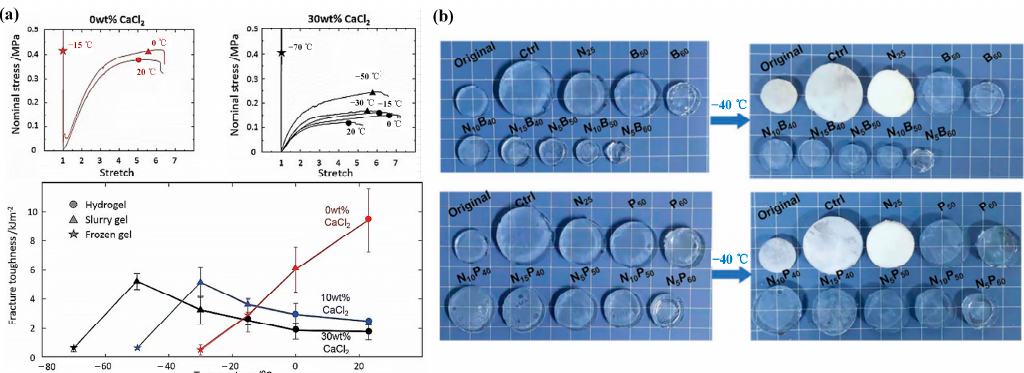
Figure 2. Effects of introducing soluble ions in solvents on the anti-freezing properties of hydrogels: ( a ) Mechanical properties and fracture toughness of hydrogels with changed CaCl 2 concentration under different temperature; ( b ) Anti-freezing behavior of NH 4 Cl/betaine or NH 4 Cl/proline based hydrogels at − 40 °C. Reprinted with permission from [17,26].